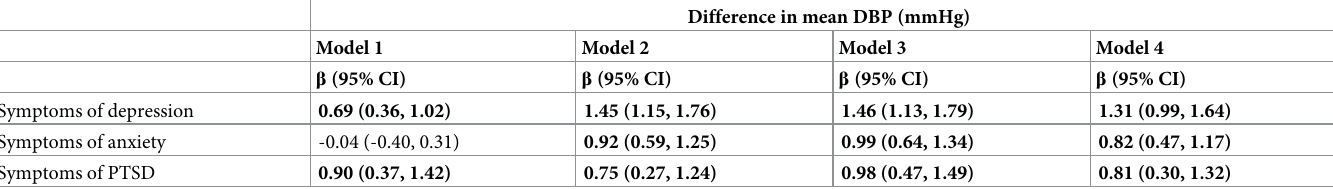
Table 4. Associations between diastolic blood pressure across probable mental